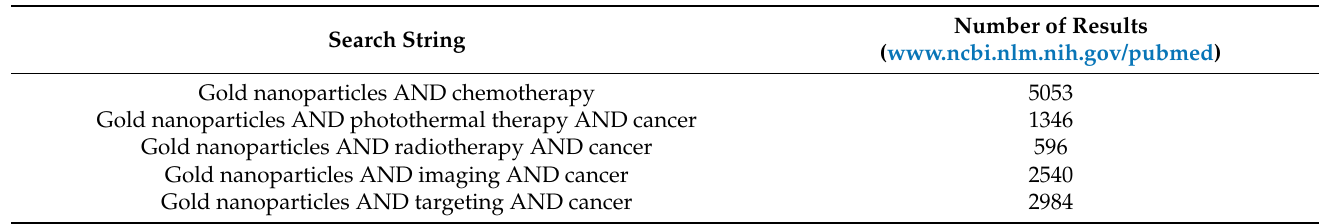
Table 1. Application of AuNPs in oncology. Search was performed on 28 May 2022 using the PubMed